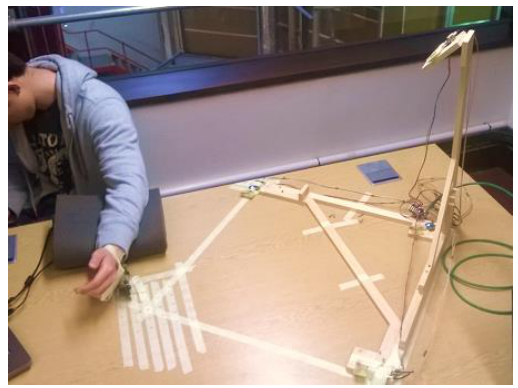
Figure 4: Localisation measurements with the mobile tag fixed on the hand of a real human test subject.